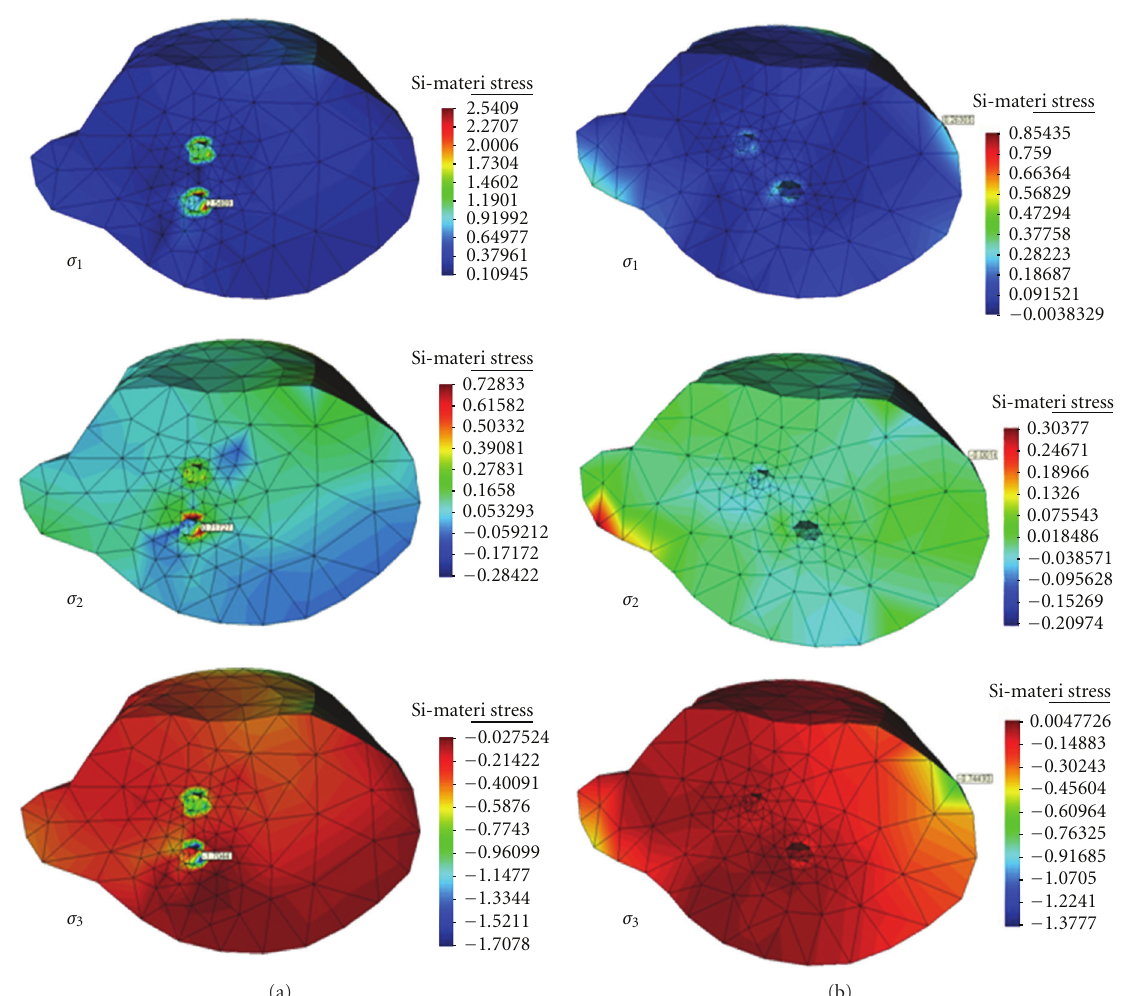
Figure 9: Predicted normal principal stress contours σ 1 , σ 2 , and σ 3 for top fracture for normal load of 50N along lateral x -direction, (a) parallel K-wire fixation, and (b) crossing K-wire